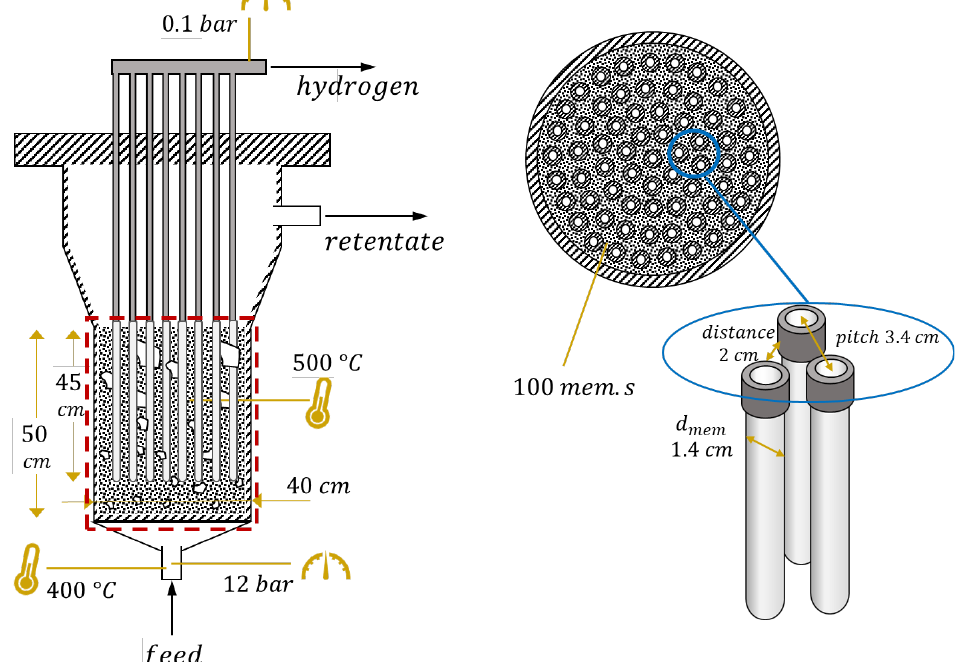
Figure 2. FBMR layout with the values of geometric and operating parameters at nominal conditions. Dense region modeled is in the red square, where the catalyst (black dots) and membranes (in white) are present.